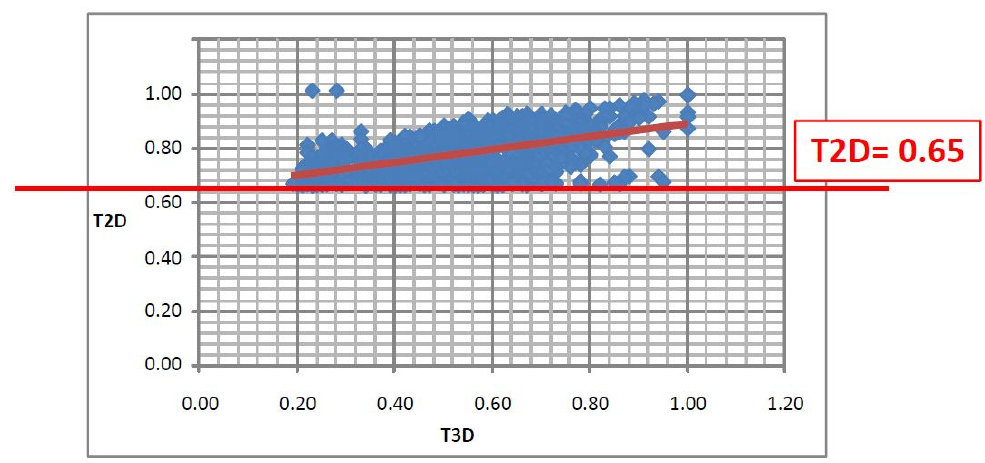
Figure 6. Correlation between the T2D and T3D